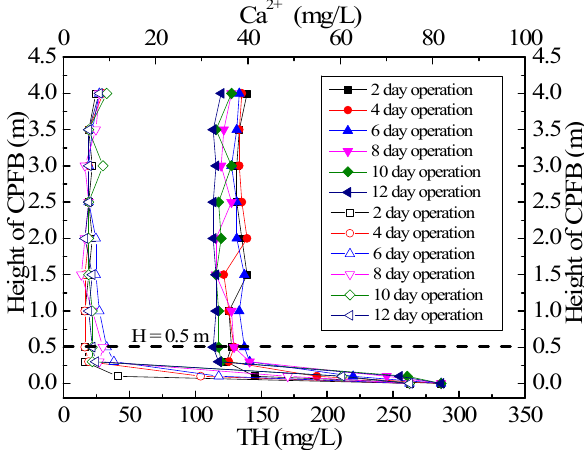
Figure 5. Removal of TH and Ca 2+ at different running times of the CPFB reactor.